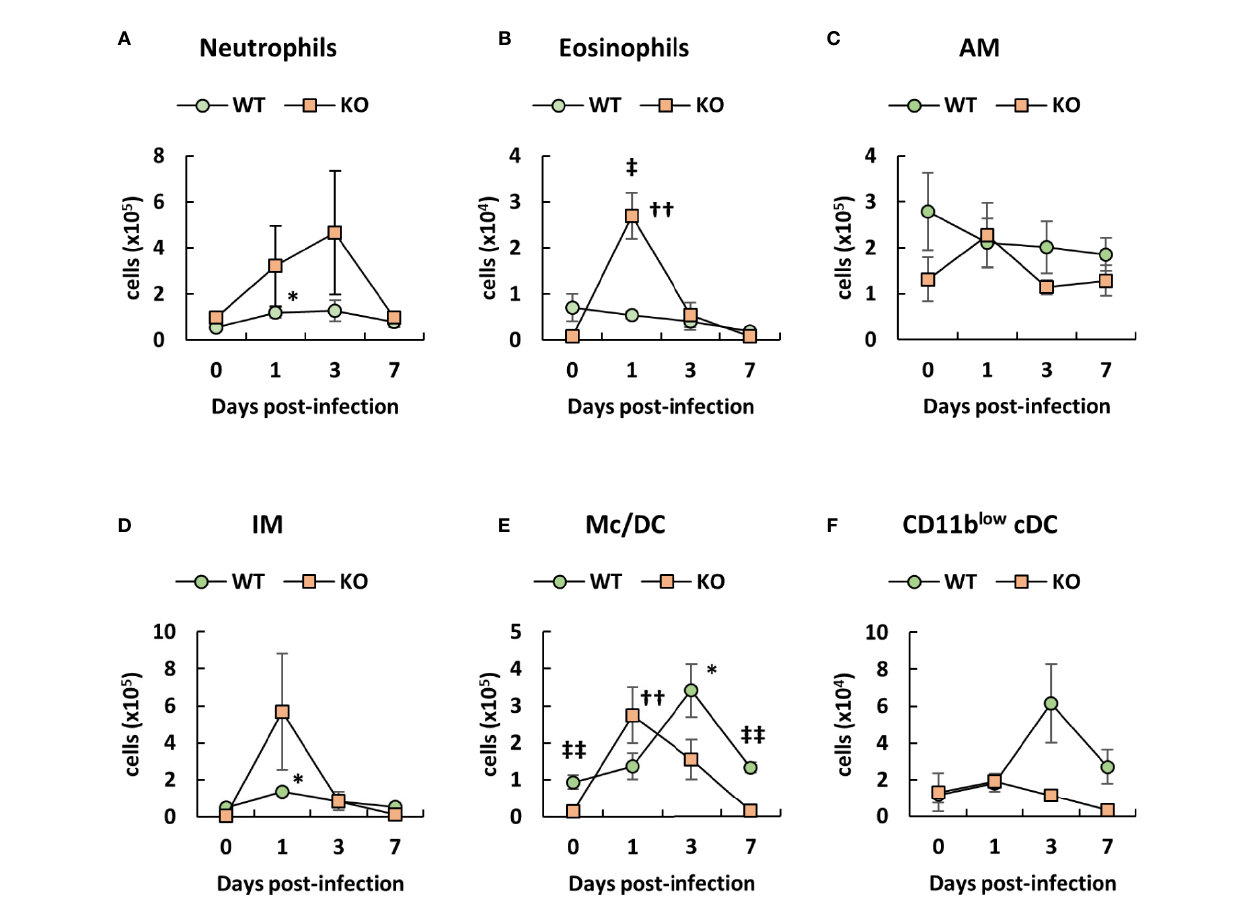
FIGURE 2 | Number of innate immune cells in the lungs of klotho wildtype (WT) and knockout (KO) mice before and after infection with Acinetobacter baumannii . Summarized results show the number of (A) neutrophils, (B) eosinophils, (C) alveolar macrophages (AM), (D) interstitial macrophages (IM), (E) monocytes/dendritic cells (Mc/DC), and (F) CD11b low conventional DC (cDC) in the lungs of A. baumannii -infected klotho WT and KO mice. Line graphs were compiled from 4 independent experiments ( n = 16 for WT and n = 15 for KO mice), and represent the mean ± SEM. Asterisks indicate statistically signi fi cant differences (* P < 0.05, klotho WT mice before infection vs. klotho WT mice after infection, Student ’ s t -test; †† P < 0.01, klotho KO mice before infection vs. klotho KO mice after infection, Student ’ s t -test; ‡‡ P < 0.01, klotho WT mice vs. klotho KO mice, Student ’ s t